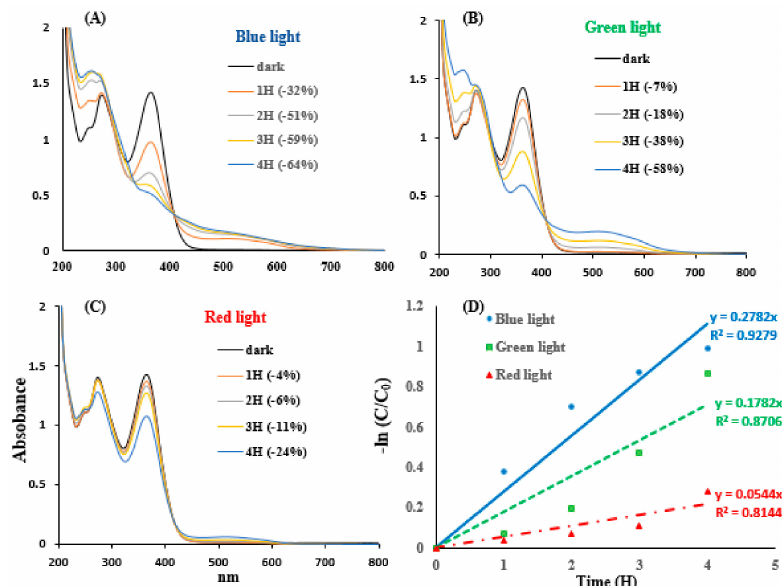
Figure 3. Spectra of 50 mg/L TC illuminated by ( A ) blue, ( B ) green, and ( C ) red light illuminations at 2.0 mW/cm 2 for 1 to 4 h. In ( D ), the k appa. of TC treated with different visible light